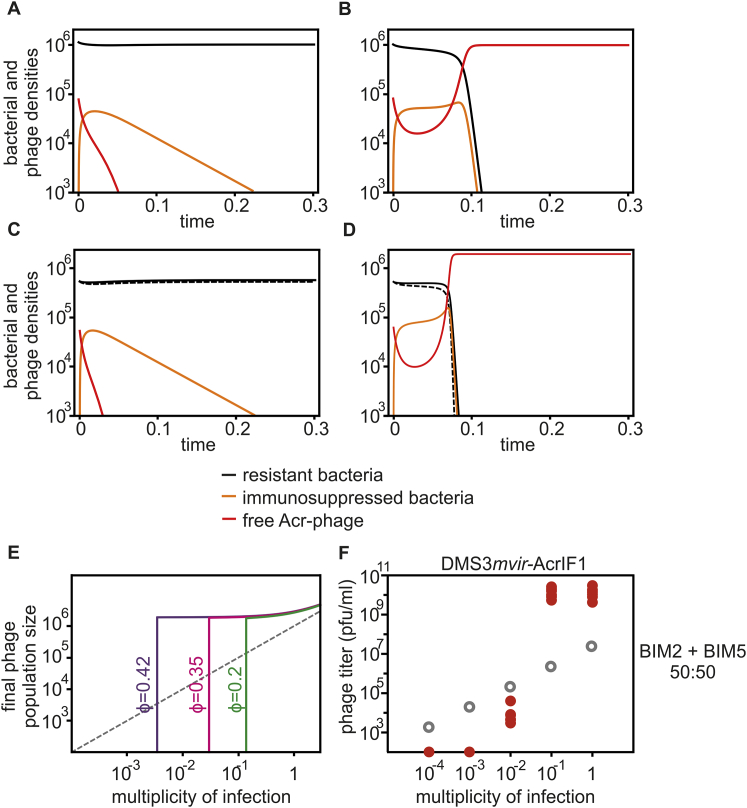
Model Predictions of the Temporal Population Dynamics of Acr-Phage and Resistant and Immunosuppressed Hosts, Related to Figure 5(A and B) Model predictions for the densities of resistant bacteria (black), immunosuppressed bacteria (orange) and phages (red) across time for two initial inoculum sizes: (A) V(0) = 5.104, (B) V(0) = 8.104. Other parameter values: R(0) = 106, B = 5, α = 0.001, γ = 20, ρ = 0.7.(C and D) Model predictions of the temporal population dynamics of Acr-phage and resistant and immunosuppressed hosts when the bacteria is initially composed of two different resistant hosts with different efficacy of resistance (ρ1 = 0.7 and ρ2 = 0.4) in equal frequency, with the densities of the two resistant bacteria (full and dashed black lines, respectively), immunosuppressed bacteria (orange) and phages (red) across time for two initial inoculum sizes: (C) V(0) = 5.104, (D) V(0) = 6.104. Other parameter values: B = 5, α = 0.001, γ = 20.(E) Effect of initial Acr-phage inoculum density on the phage density at 24 hpi for different values of Acr efficacy (ϕ = 0.42 (purple), ϕ = 0.35 (magenta) and ϕ = 0.2 (green)) when the bacteria is initially composed of two different resistant hosts with different efficacy of resistance (ρ1 = 0.7 and ρ2 = 0.4) in equal frequency. Other parameter values: B = 5, α = 0.001, γ = 20.(F) Viral titers at 24 hpi of a 50:50 mix of BIM2 and BIM5 with 104, 105, 106, 107 or 108 pfus DMS3mvir-AcrIF1. Grey circles indicate the phage titers (pfu/ml) at the start of the experiment. Colored points represent phage titers at 24 hpi; each data point represents an independent biological replicate (n = 6). The limit of detection is 200 pfu/ml.